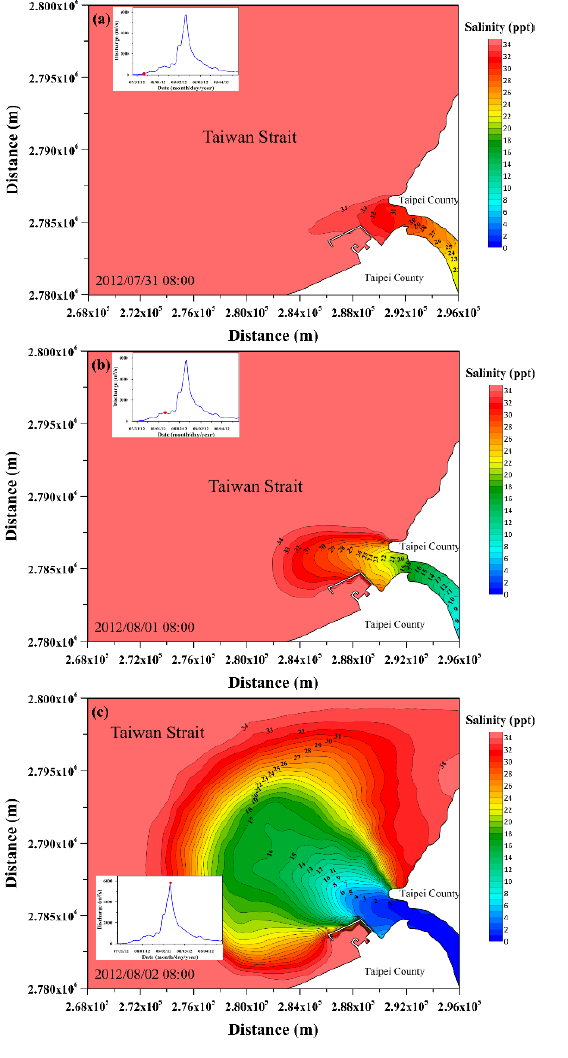
Figure 7. Snapshots of the surface salinity distributions during Typhoon Saola in 2012 for different periods: ( a ) 08:00 July 31, ( b ) 08:00 August 1, ( c ) 08:00 August 2, ( d ) 08:00 August 3, and ( e ) 08:00 August 4. Table 6. Plume distances and plume areas for different periods during Typhoon Saola (2012).